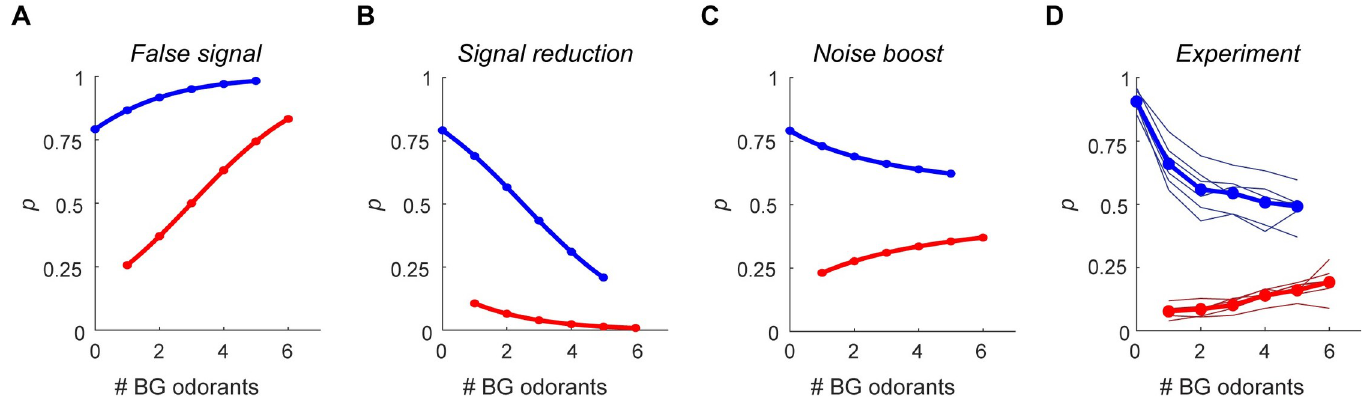
Fig 2. The effect of background odorants on decision probabilities. A-C. The probability of reporting that the target odorant is present ( p ) (see Eq 2, Methods) as a function of the number of background odorants, for the three interference hypotheses: false signal ( A ), signal reduction ( B ), and noise boost ( C ). Blue–“target on” trials, ¼ 2; A 0 ¼ (cid:0) 2 : 5; c 2 ¼ 3 . The drift rate under the false signal, the signal reduction and the noise red–“target off” trials. Baseline parameter values are θ = 1; m = 0; A 0 þ (cid:0) 0 boost mechanisms are: A ¼ A 0 þ k � BG ; A ¼ A 0 (cid:0) k � BG and A ¼ A 0 , respectively, where i 2 {+, − } and # BG is the number of background odorants in the mixture and i i i i i i þ k � BG under the noise boost mechanism and c 2 ¼ c 2 in the false signal and signal reduction mechanisms. D. The fraction of trials that k = 1. The diffusion is c 2 ¼ c 2 0 0 mice reported that the target is present as a function of the number of background odorants. Thin lines show data from individual mice. Thick lines show the mean across mice. Colors as in